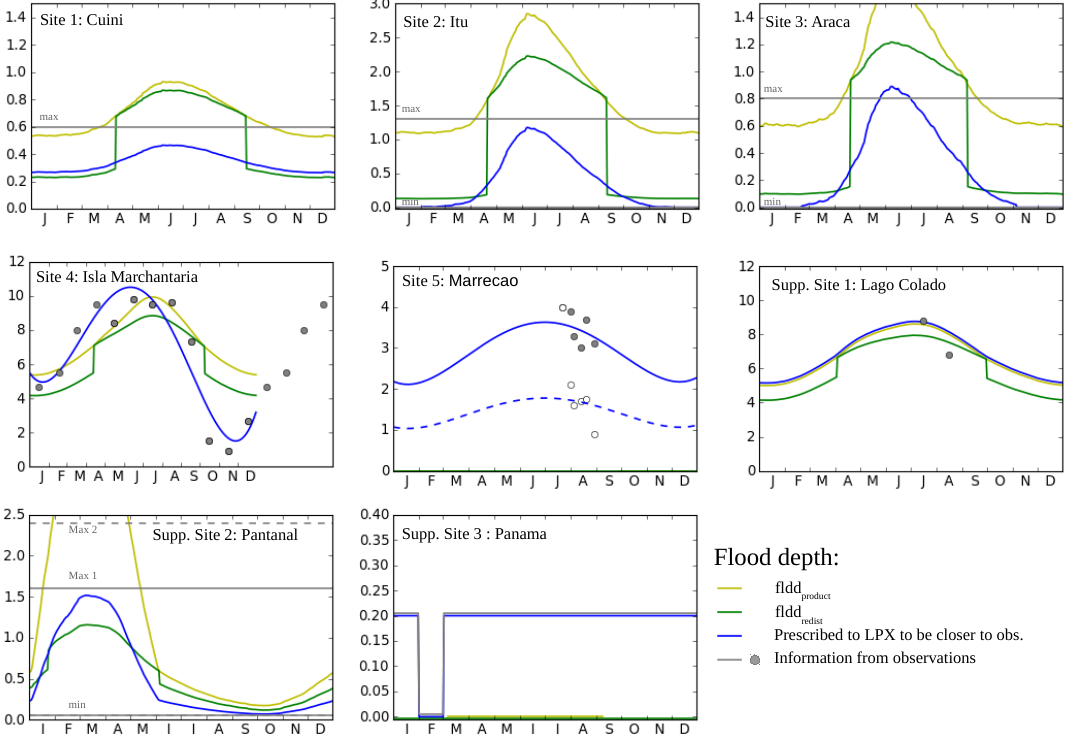
Fig. A4. Seasonal cycle of flood depth prescribed to LPX for simulations on sites. Both flood depth computed using PCR-GLOBWB (fldd redist in green and fldd product in yellow) and flood depth prescribed to account for information on sites (blue) are plotted. Field informa- tion used to draw blue curves are given in grey and are from reference papers of each site (see Table 2). On sites 1, 2, 3 and Supp. Site 2, information given in reference papers corresponds to yearly maximum/minimum values. On site 5, observed flood depths for plots with both flooded forests (white-filled circles) and floating macrophytes (grey-filled circles) are explicitly